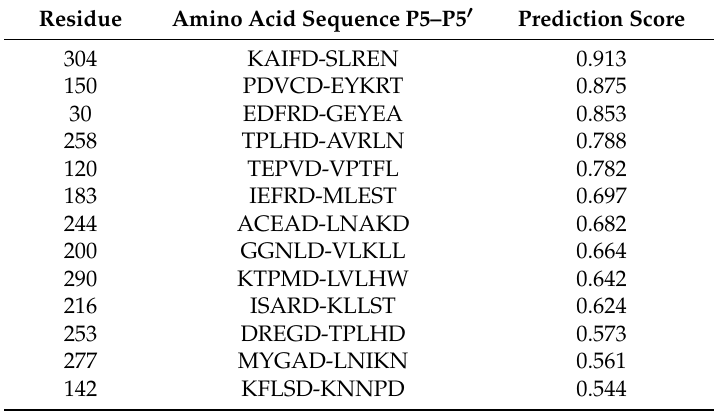
Table 4. Caspase cleavage sites in ANKRD1 predicted from CaspDB database